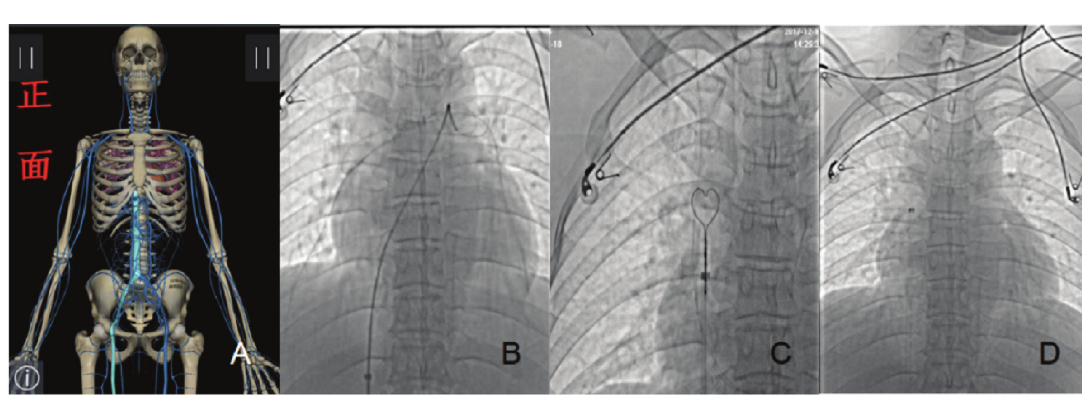
Figure 3. Images obtained during pulmonary artery angiography and intravascular removal of foreign matter by using (A) a pigtail catheter thread through the iliac vein, inferior vena cava, right atrium, and right ventricle pulmonary artery and (B) the guide wire wrapped around the fractured catheter; (C) shows the extraction of the fractured catheter out of the pulmonary artery and its guidance into the inferior vena cava; and as the heart contracted, the broken tube drifted into the superior vena cava and the internal jugular vein. We inserted the goose neck snare through the iliac vein, inferior vena cava, right atrium, and superior vena cava and opened the goose neck ring waiting for the exposed free fractured catheter to drift into the ring; and (D) shows the tightening of the ring, indicating it slowly being drawn through the right atrium, inferior vena cava, iliac vein, and femoral vein. Finally, the fractured catheter is successfully removed.